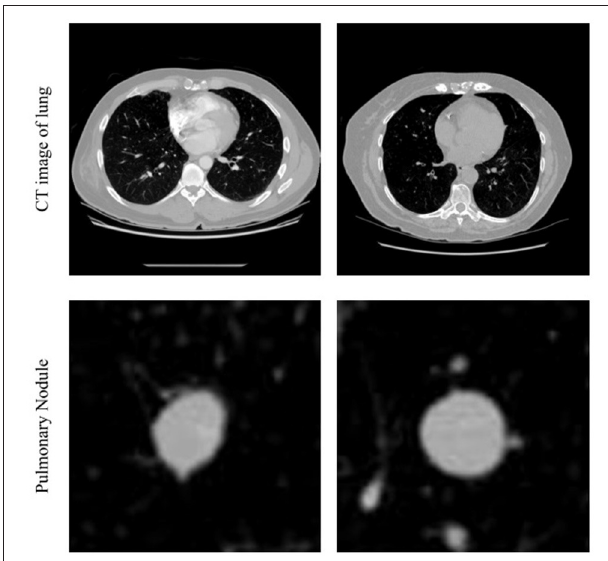
FIGURE 1 | Example of CT images in lung and pulmonary